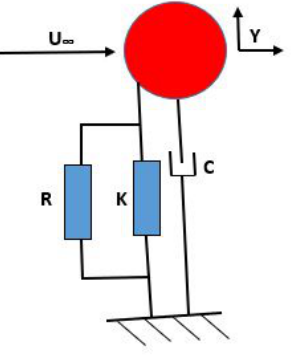
Figure 6. Cylinder-based piezoaeroelastic energy harvester subjected to free stream velocity U ∞ ; R is the electrical load resistance; C and K are structural damping and